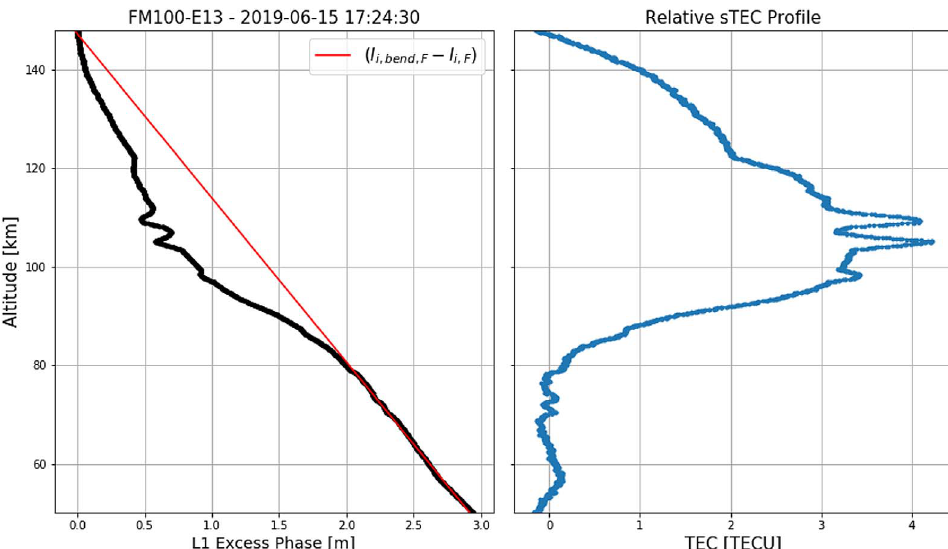
Fig. 2. Bottom-up processing applied to Spire high-rate (50 Hz) excess phase data in order to estimate relative sTEC pro fi les. The left panel shows the L1 excess phase pro fi le (black) for Spire satellite FM100 from Galileo E13 and the linear contribution of the F region estimated from the pro fi le below 80 km. The right panel shows the relative sTEC pro fi le that is obtained after removal of the linear